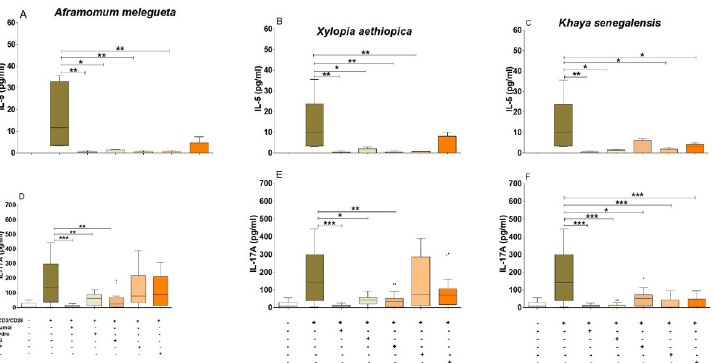
Fig 7. Effect of deglycosylation, deproteinization or delipidation of the hydro-ethanolic extracts of Aframomum melegueta , Khaya senegalensis and Xylopia aethiopica . PBMCs (2x105 cells) from endemic normal individuals (n = 16) were activated with α CD3/ α CD28 (0.5 beads/ μ l) in the presence or absence of Ibumol, hydro-ethanolic extracts (Hydro), deglycosylated (DG), deproteinized (DP) or delipidated (DL) fractions of Aframomum melegueta (AM), Khaya senegalensis (KS) and Xylopia aethiopica (XA) (200 μ g / ml) for 3 days. Box whiskers (tukey) with outliers show levels of IL-5 (A, B and C) and IL-17A (D, E and F). Asterisks show statistical differences (Mann-Whitney-U test) between the groups indicated by the brackets ( � p < 0.05, �� p < 0.01, ��� p < 0.001).